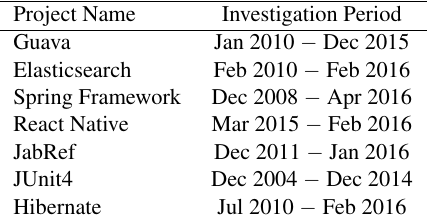
Table 1. Surveyed OSS